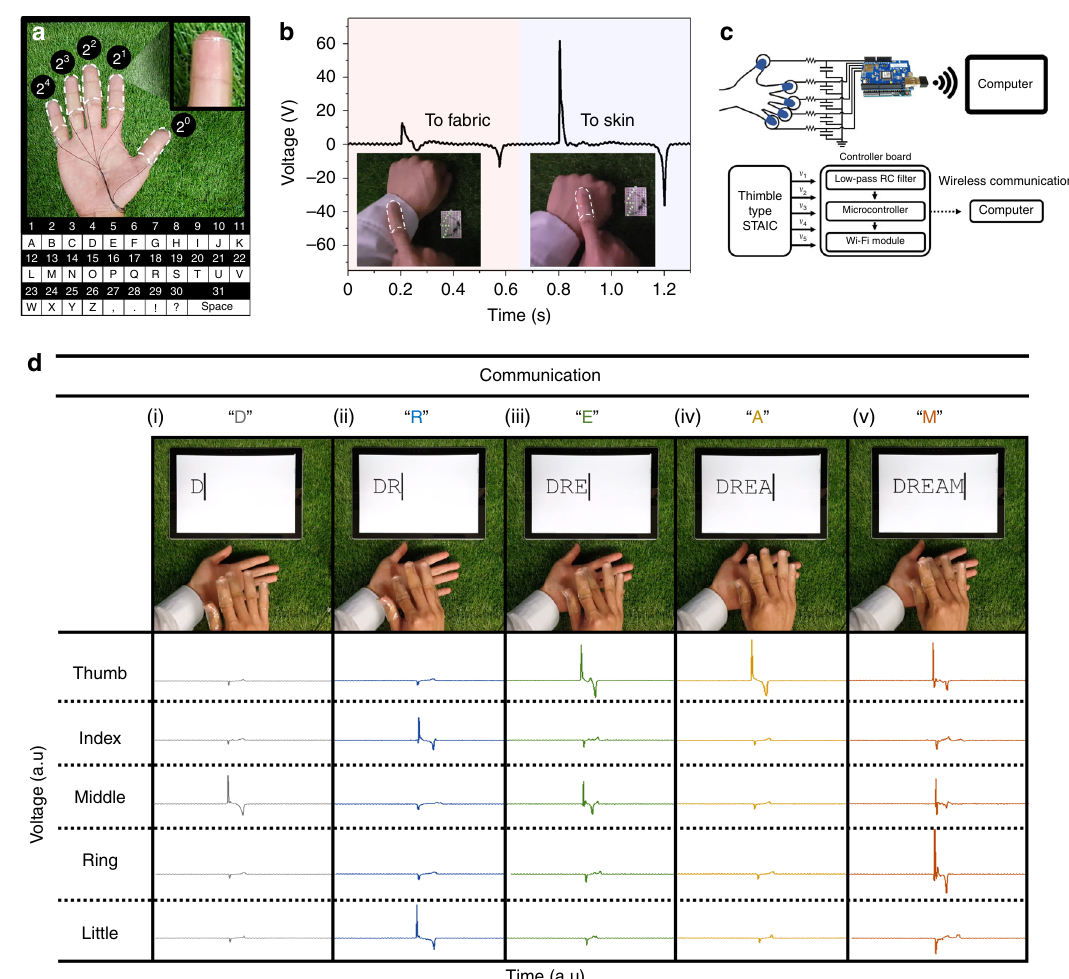
Fig. 4 Wireless real-time communication. a Self-cleanable, transparent, and attachable ionic communicators (STAICs) were attached on the fi ngers and connected with wires to a controller board. A different order of a binary system was assigned to each fi nger, and the letters were pre-coded in the microcontroller. b Generated voltages of a STAIC by a gentle touch to a fabric and the skin. c Block diagram of the communicator based on STAICs. STAICs were connected to a controller board which contains an RC low-pass fi lter, a microcontroller and a Wi-Fi module. d Demonstration of real-time communication with STAICs. “ DREAM ” was typed using combinations of fi nger